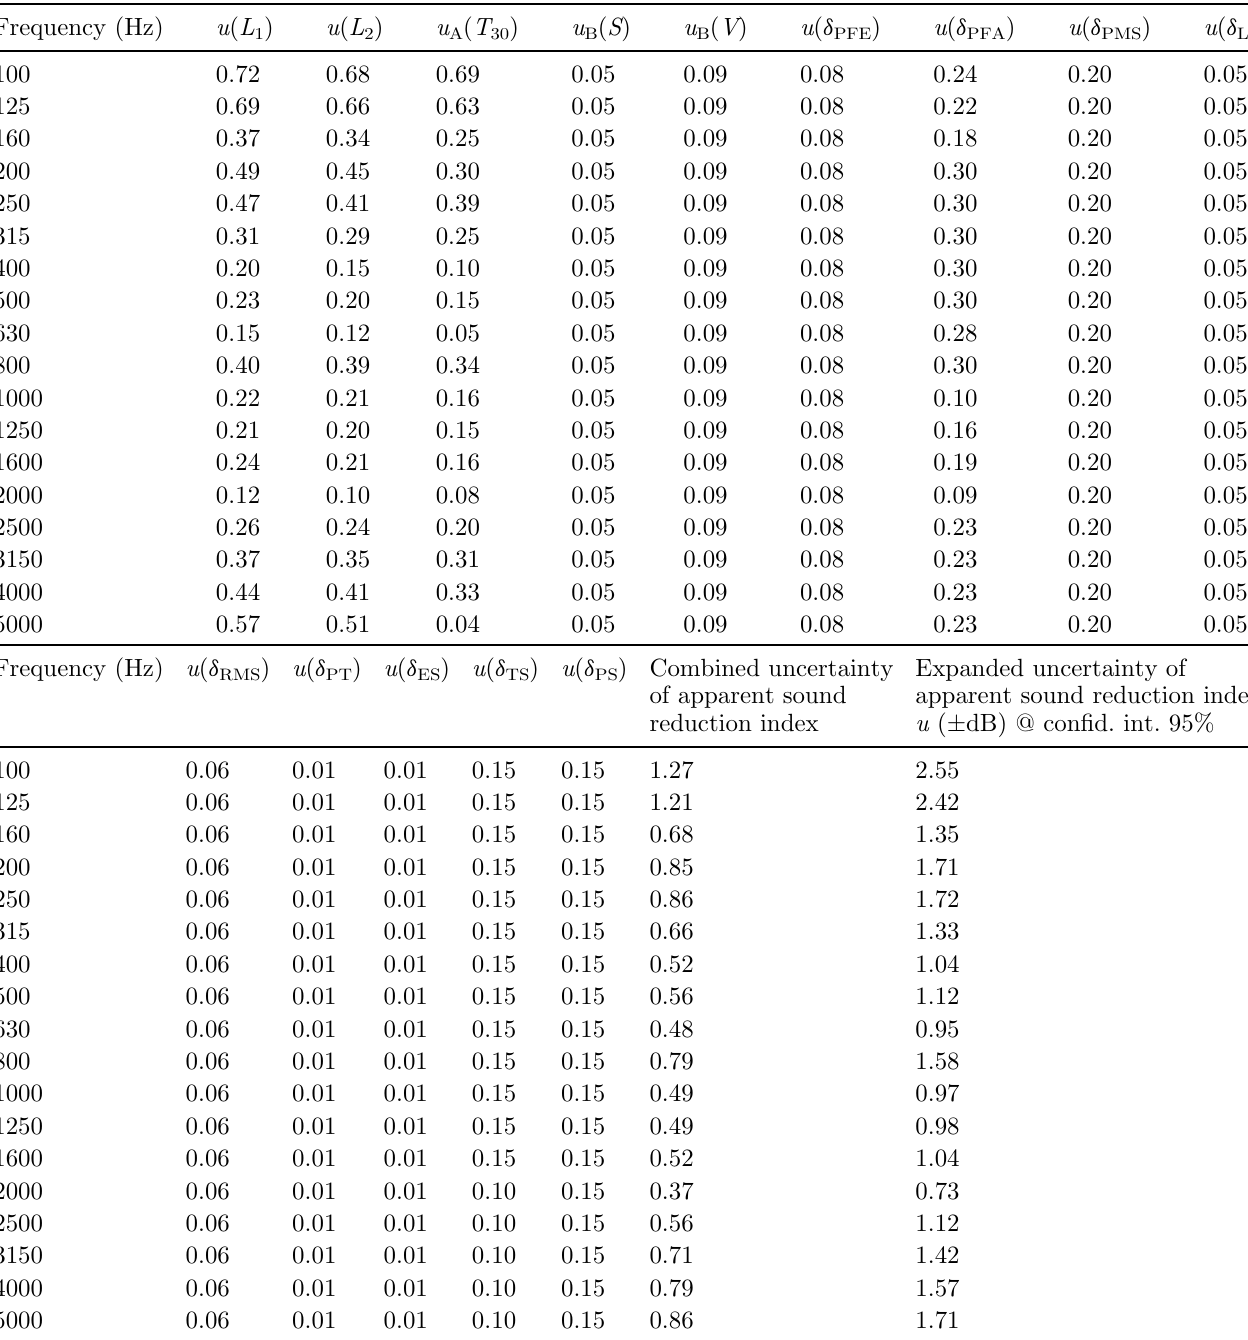
Table 2. The determined expanded uncertainty of apparent sound reduction index measurement in 1/3-octave bands from 100 Hz to 5000 Hz